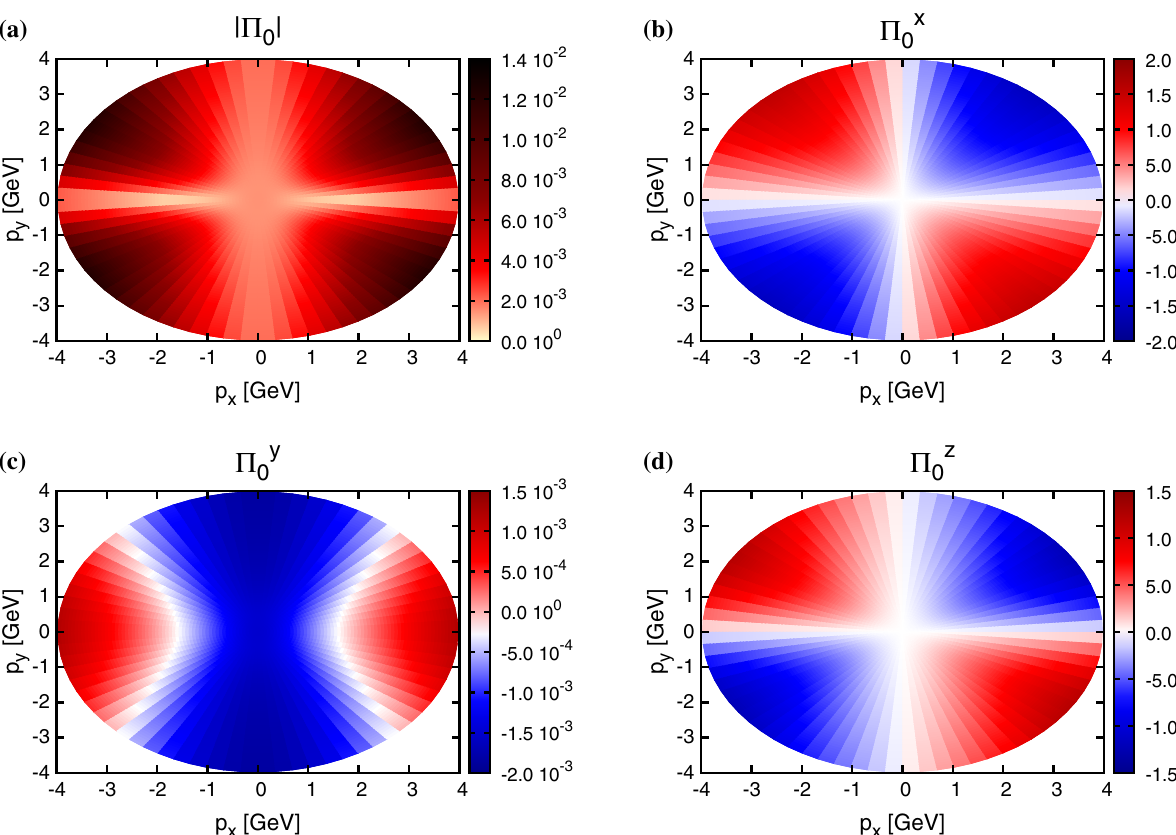
Fig. 14 Magnitude ( a ) and components ( b – d ) of the polarization vector of the (cid:7) hyperon in its rest frame